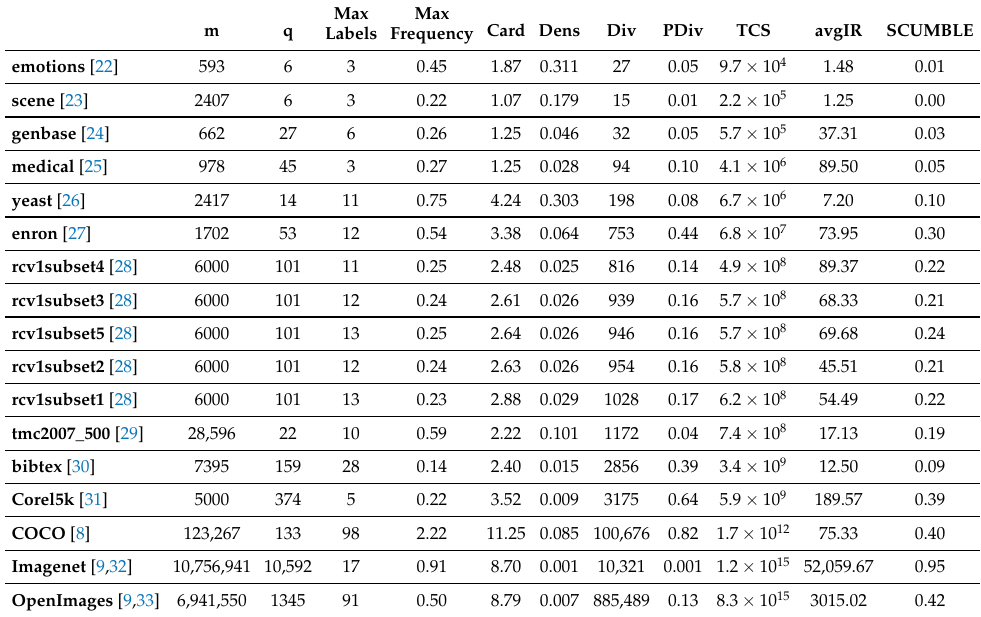
Table 1. Imbalance measures of different multi-label data sets: size of data set (m), number of labels (q), max number of labels in an example of the data set (Max Labels), maximum frequency of a label in the data set (Max Frequency), label cardinality (Card), label density (Dens), label diversity (Div), normalized label diversity (PDiv), theoretical complexity score (TCS), average imbalance ratio per label (avgIR), and SCUMBLE. Well-known multi-label data sets (top) have smaller size and lower complexity than data sets currently used in computer vision applications (bottom). Data sets are ordered by theoretical complexity score. These data sets will be used in the validation of the different methods presented in this paper. m